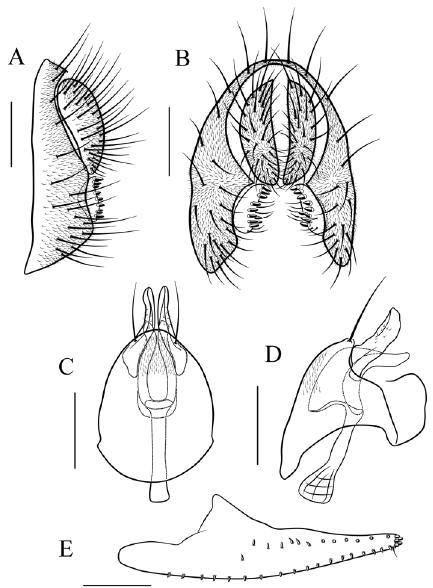
Figure 11. Scaptodrosophila maculata sp. n. A, B epandrium, surstylus and cercus (lateral and posterior views) C, D hypandrium, parameres, gonopods, aedeagus and aedeagal apodeme (ventral and lateral views) E oviscapt (lateral view). Scale bars 0.1